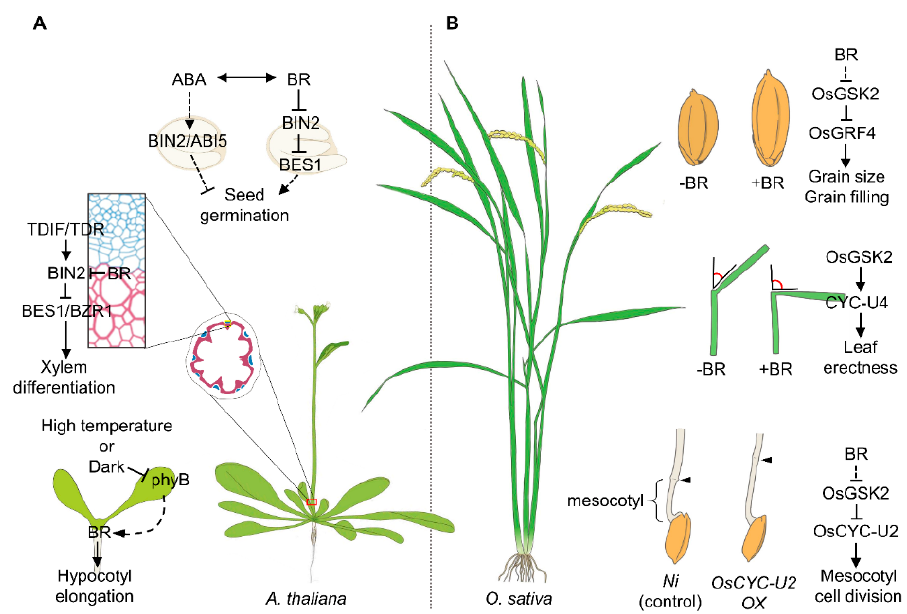
Figure 2. A schematic diagram of BR-mediated development and growth regulation in plants. BR regulates the development and growth of dicot ( A ) and monocot ( B ). BR promotes seed germination through the canonical signaling pathways by inhibiting the abscisic acid (ABA)-mediated seed dormancy. BR signaling enhances the xylem formation during secondary growth. Under the high- temperature condition, thermosensing at cotyledon initiates the BR-induced hypocotyl elongation through intracellular interaction ( A ). BR signaling enhances the grain size and mesocotyl elongation in rice. The cell division regulation by BR signaling determines the leaf inclination ( B ).